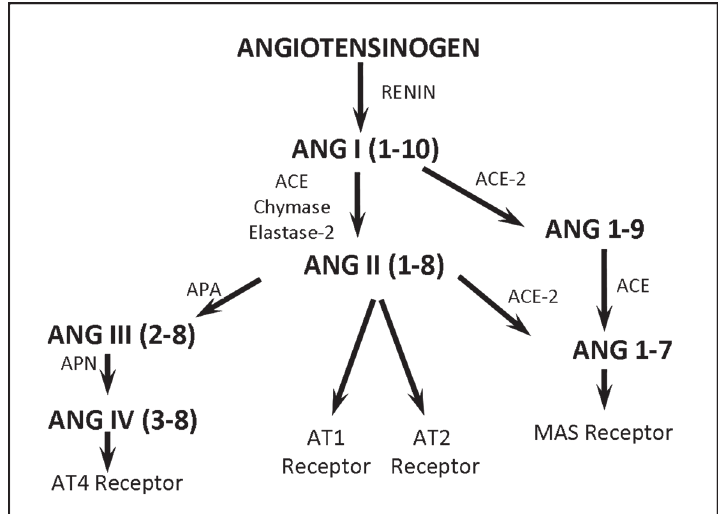
Figure 1. Representative peptides, enzymes, and receptors of the renin-angio- tensin system. ANG = angiotensin; ACE = angiotensin-converting enzyme; ACE- 2 = angiotensin-converting enzyme-2; APA = aminopeptidase A; APN = amino- peptidase